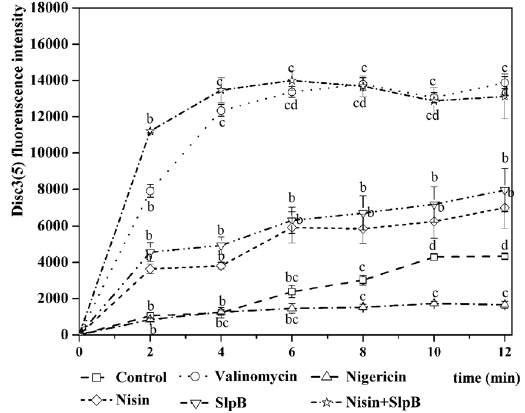
Figure 7. Δψ in S. saprophyticus P2 cells. Samples were taken at regular intervals from control cells and following supplementation with nigericin, valinomycin, SlpB, nisin, or nisin + SlpB. Different letters in the curve indicate significant difference (p < 0.05).